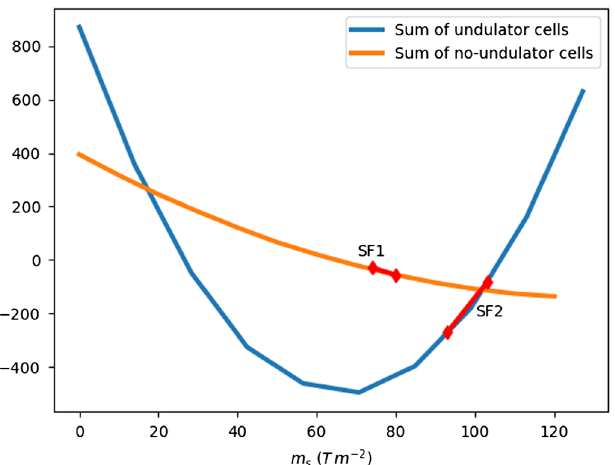
FIG. 7. Sums of second-order chromaticities (horizontal plus vertical) over the total number of cells in the ring. The horizontal axis shows sextupole strength in two different cell types, and the regions highlighted in red correspond to the ranges of strengths for linear chromaticity compensation used in the